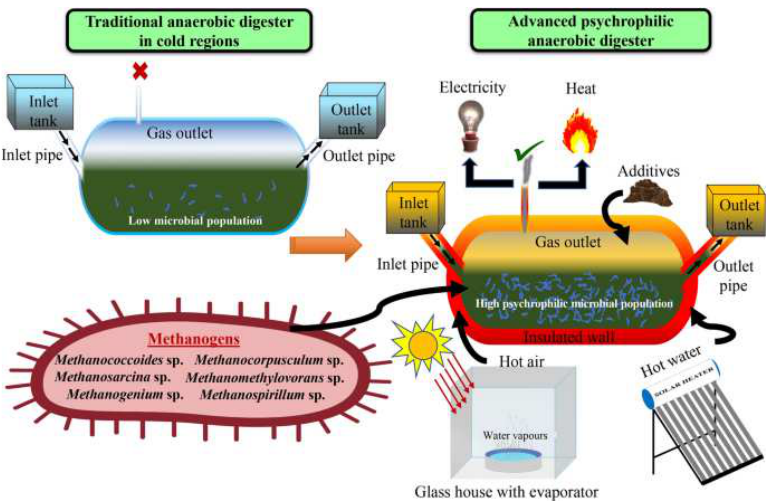
Figure 1. Features to improve biomethanation under low temperatures. Reprinted from Manyapu, Kumar [24].